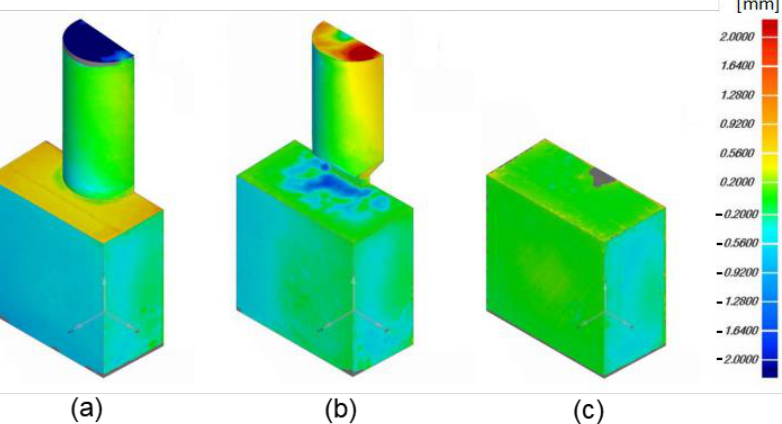
Figure 10. Scanning results of the prototypes poured at 1350 °C: ( a ) Prototype A1, smooth surface; ( b ) Prototype B1, surface sink around the riser neck; ( c ) Prototype C1, a hole at the top surface.